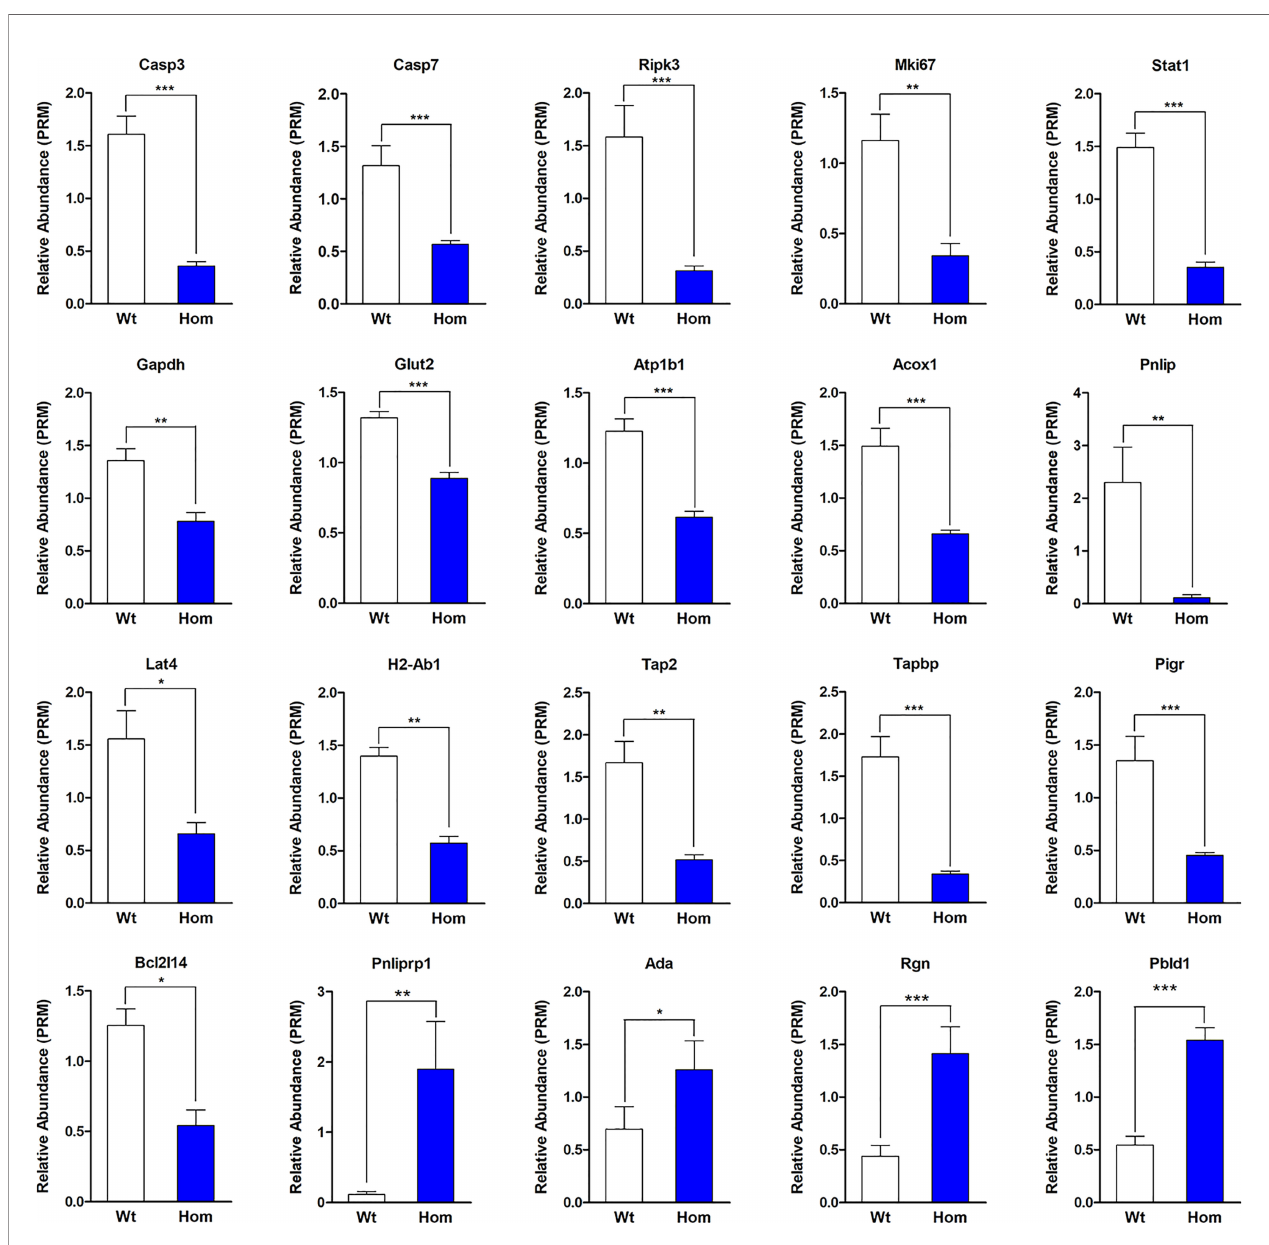
FIGURE 6 | Validation by parallel reaction monitoring analysis. The absolute quanti fi cation levels of 20 differentially expressed proteins were evaluated in Thra +/+ ( n = 4) and Thra E403X/E403X mice ( n = 5). Data are presented as mean ± SEM. Statistical analysis was performed by Student ’ s t -test. * P <0.05; ** P <0.01; *** P